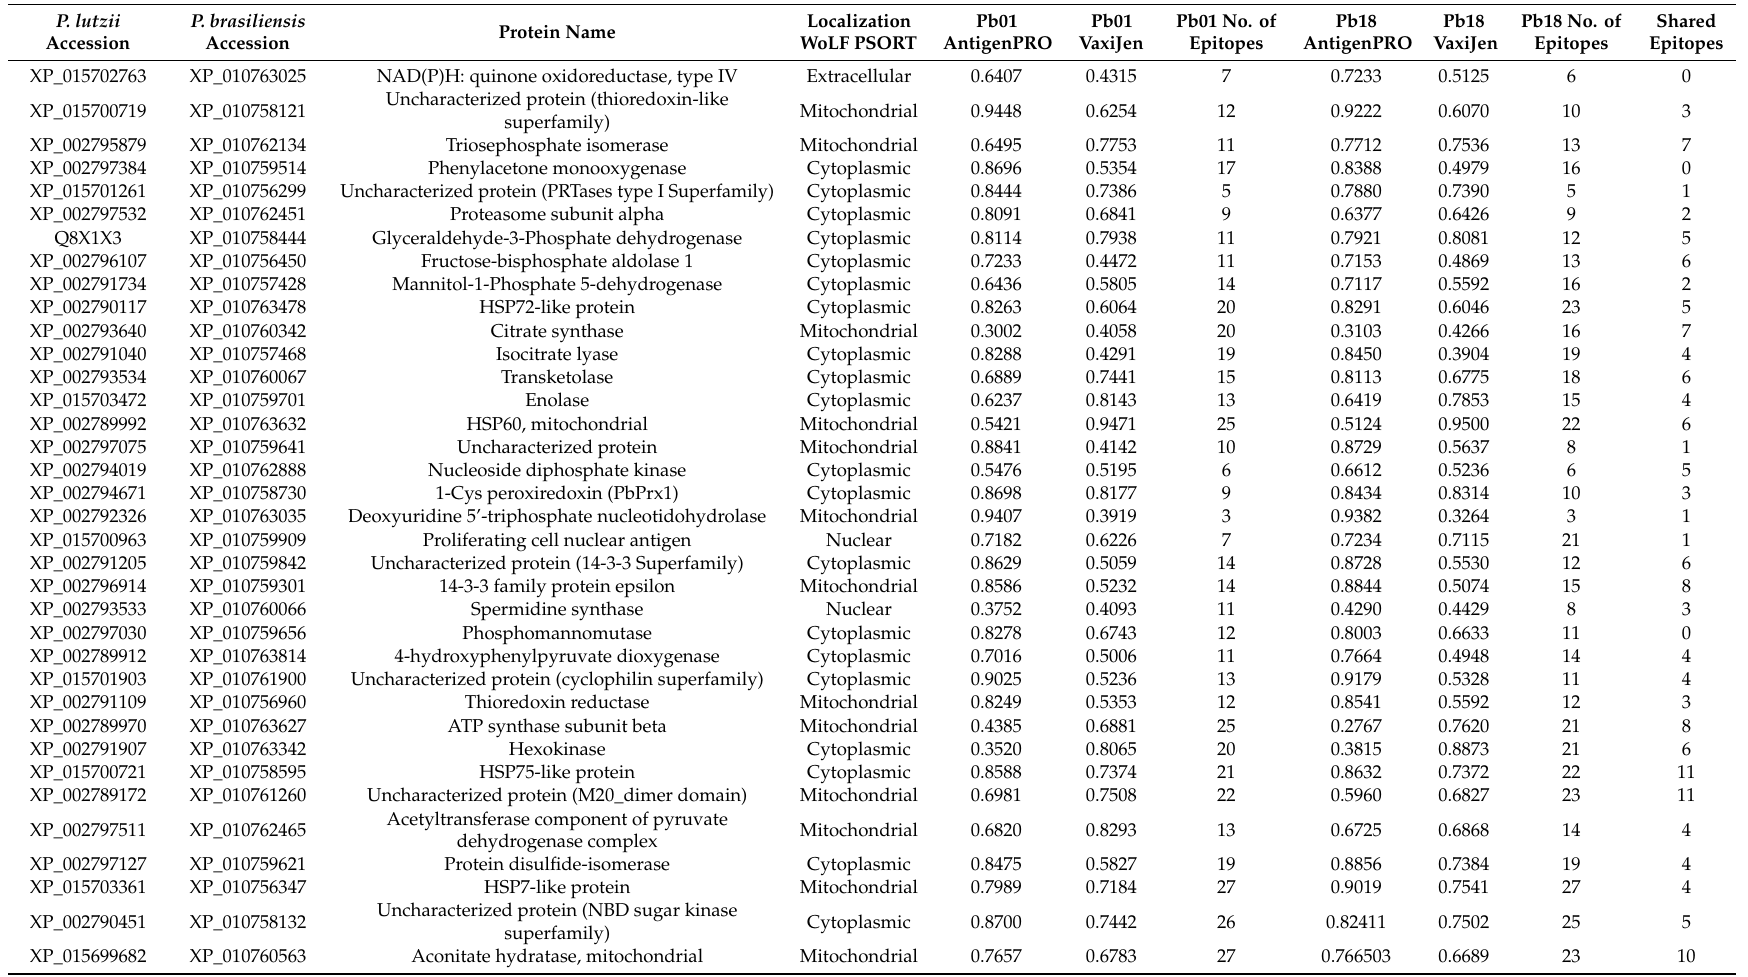
Table 3. Characterization of full-length immunoreactive proteins of Paracoccidioides spp., for predicted antigenicity using AntigenPRO and